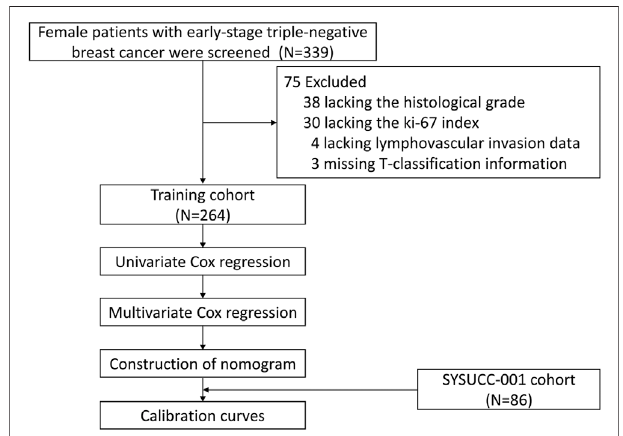
FIGURE 1 | Flow chart of patient selection in this